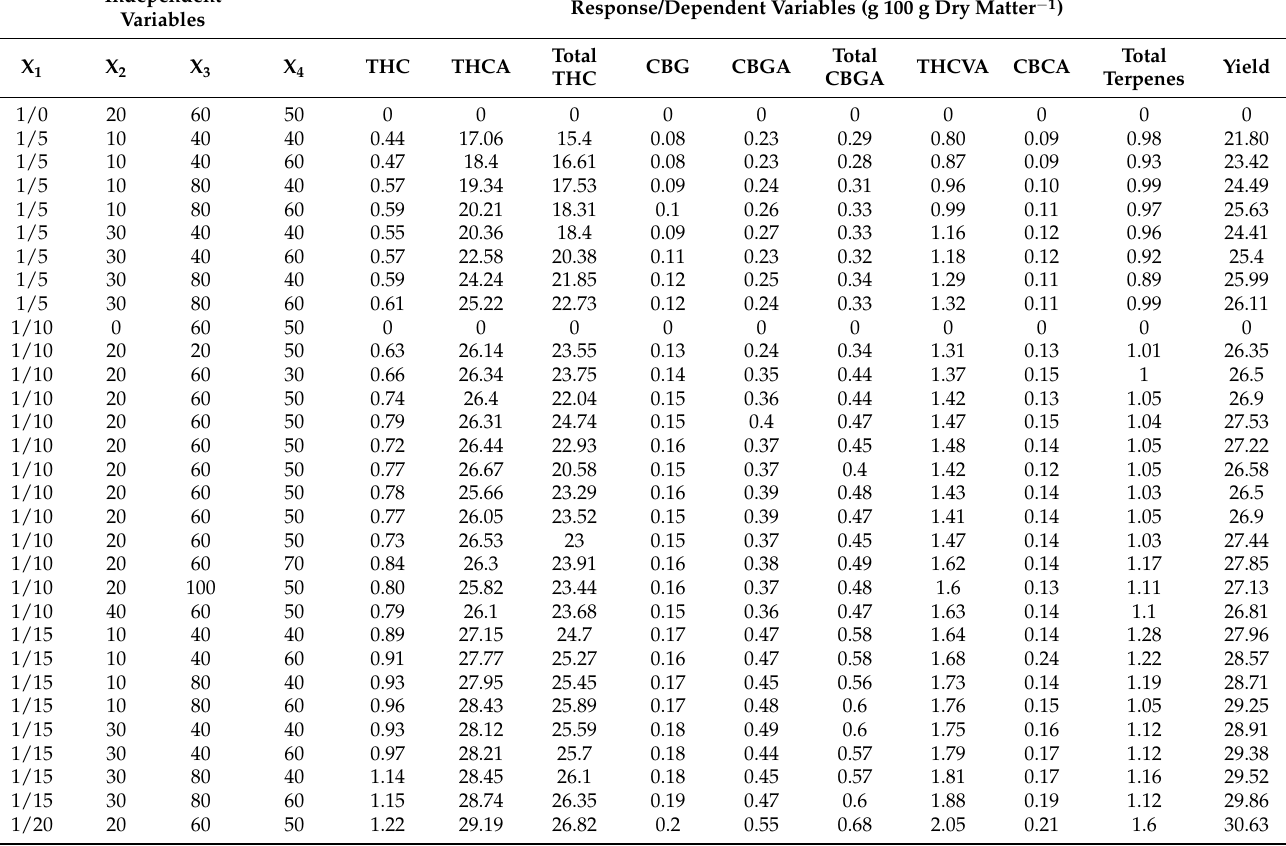
Table 2. Crude cannabis oil yield and concentration of cannabinoids and total terpenes obtained from cryo-ground cannabis subjected to ultrasound-assisted